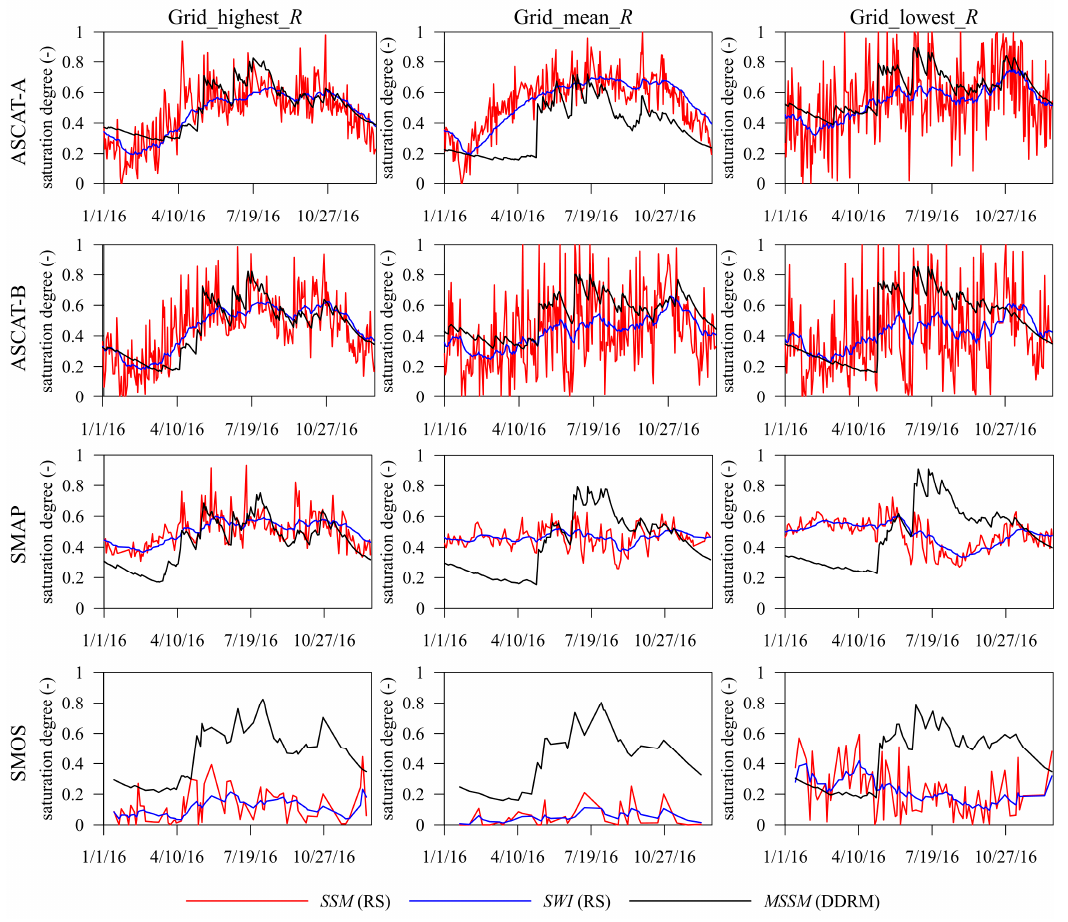
Figure 13. Time series of remotely sensed soil moisture ( ω RS and ω RS ) and model-simulated soil moisture ( MSSM ), which is denoted as ω DDRM in three kinds of grids (grids which show the highest, mean and lowest correlation coefficient between ω RS and ω DDRM ) over a one-year period of 2016. For one given remotely sensed product ( each row ), locations of grids which show the highest, mean and lowest correlation coefficient are different. For different remotely sensed products ( each column ), locations of one given kind of grids, e.g., grids show the highest correlation coefficient (Grid_Highest_ R ), are also different.